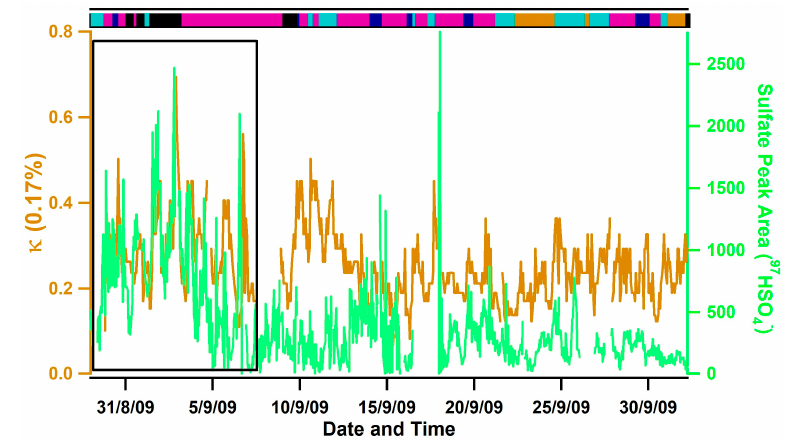
Figure 5. Temporal plot of the average κ observed at 0.17% supersaturation (orange trace) and the average sulfate ion peak area observed by ATOFMS (green trace). A bar illustrating the airmass classification ( top panel , magenta is Mixed Coastal, black is Southerly/Mexico, cyan is Los Angeles/Long Beach, orange is Inland, dark blue is Oceanic) is also shown. The black box highlights the time period when sulfate and κ were high during Southerly transport conditions.